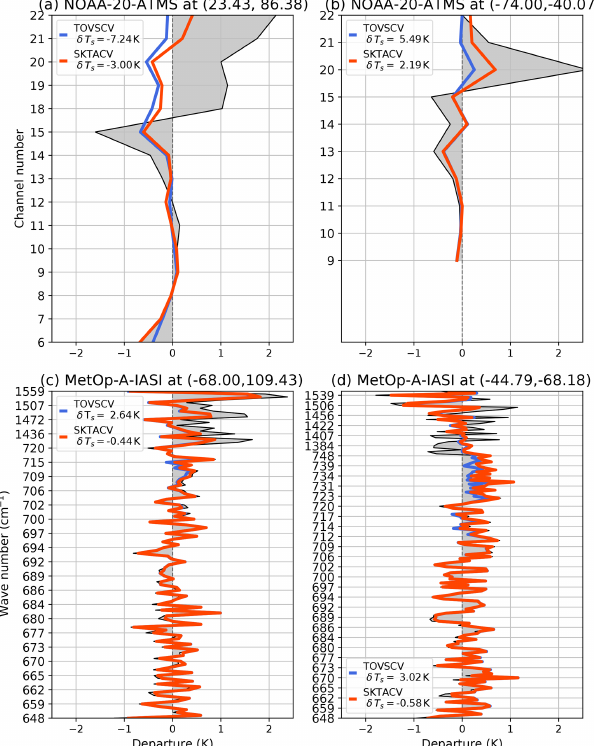
Figure 5. First-guess (grey shading) and analysis (coloured lines) departures (in K) for ATMS (a, b) and IASI (c, d) for four particular scenes; see the plot titles for the location (latitude, longitude) of the scenes. Blue denotes departures from the TOVSCV experiment, and red denotes departures from the SKTECV experiment. In the legend, δT s is the value of the skin temperature